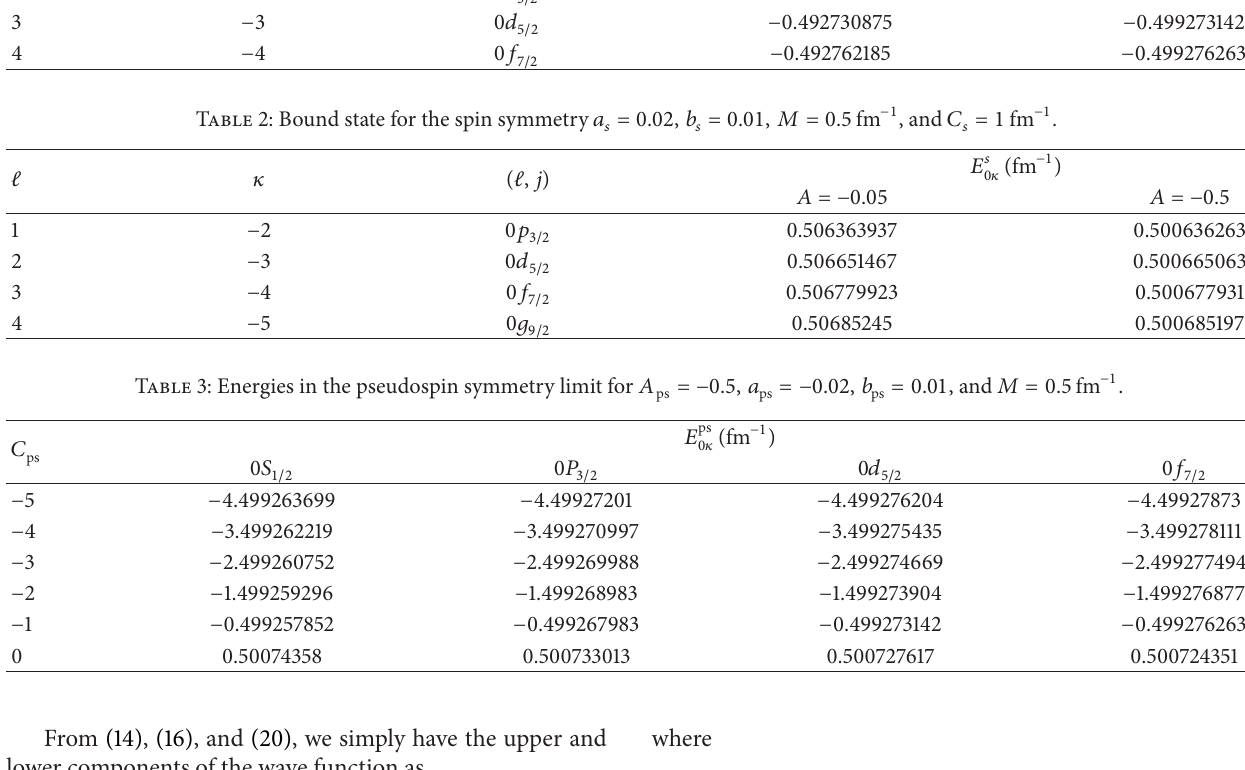
Table 1: Bound state for the pseudospin symmetry 𝑎